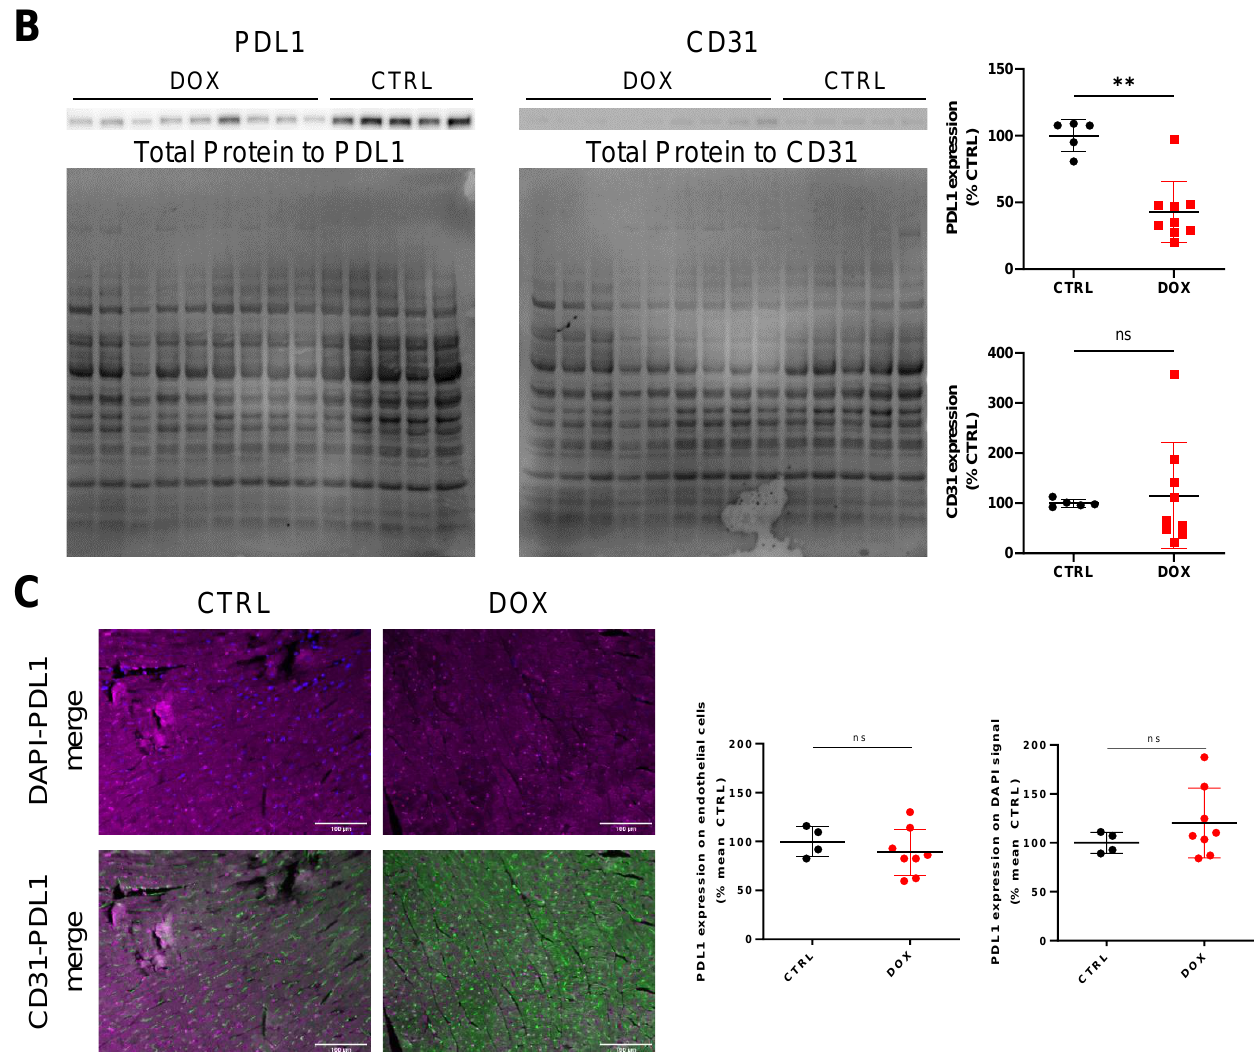
Figure 4. Immuno-histological and Western blot validation of flow cytometry findings. ( A ) Left Exemplary micrographs of DAPI, CD31 and PDL1 expression (with secondary Ab control) in cardiac tissue from control (CTRL) and Doxorubicin (DOX) treated animals. Right Quantified CD31 and PDL1 signal intensity over whole tissue normalized to CTRL group (n = 4–8, Mann–Whitney test, *: p < 0.05). ( B ) Left Western blot micrographs stained for PDL1 and CD31 from whole tissue lysates with corresponding total protein stains. Right Quantified expression of PDL1 and CD31 from micrographs on the left normalized to CTRL group (n = 5–9, Mann–Whitney test, **: p < 0.01) ( C ) Left and Middle Exemplary merged micrographs of DAPI-PDL1 and CD31-PDL1 from CTRL and DOX groups. Right Quantified PDL1 signal intensity co-localized with DAPI and CD31 signal (n = 4–8, Mann–Whitney test). Scale bars depict 100 µ m. ns: not